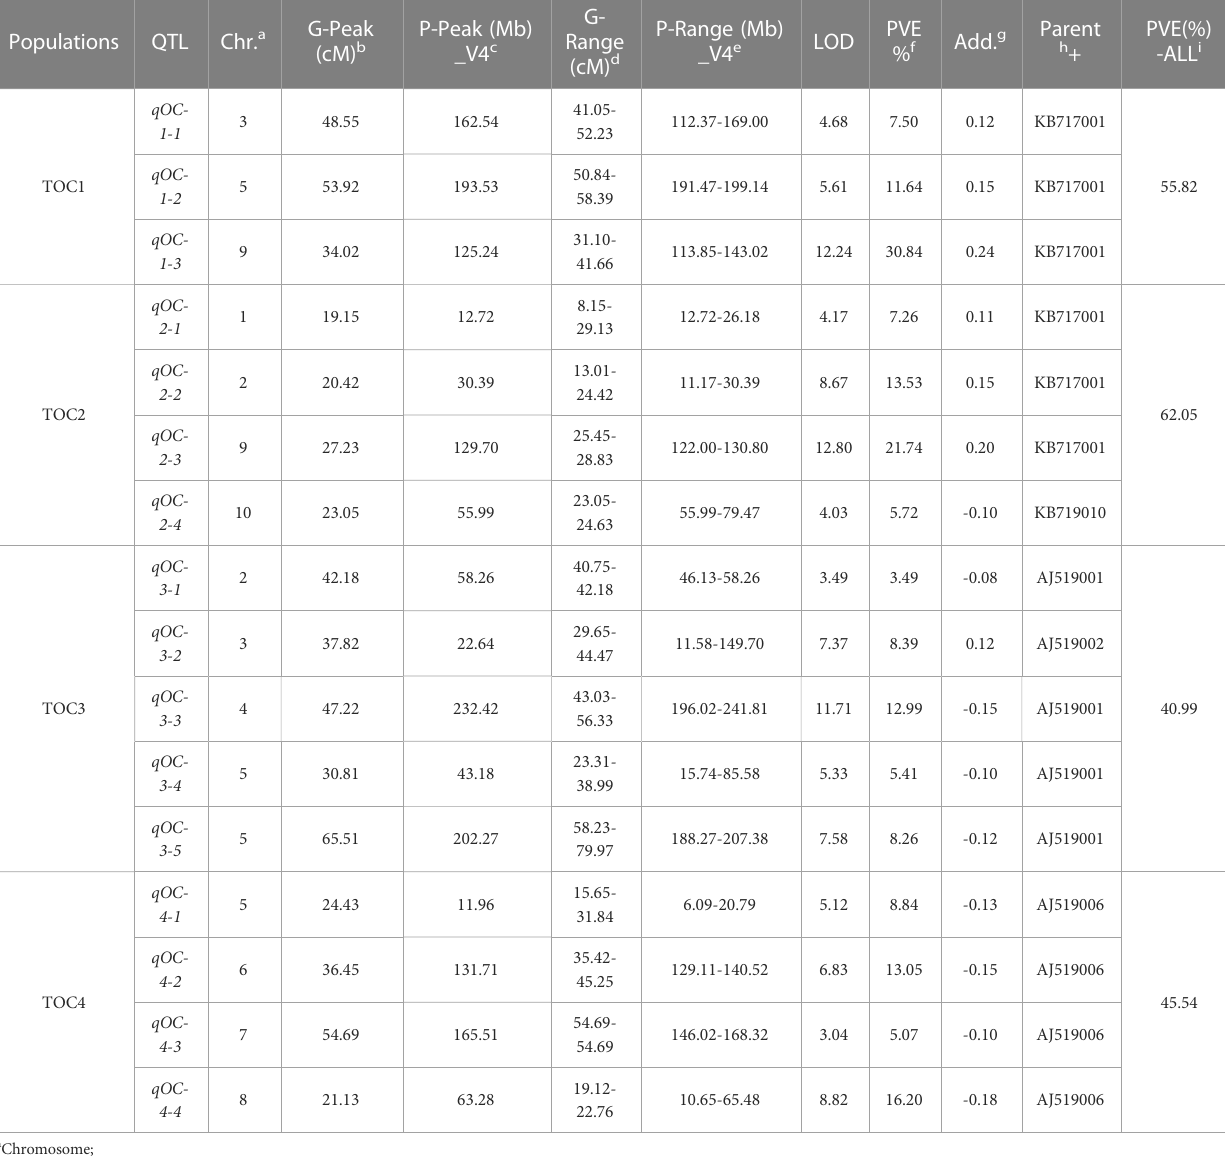
a Chromosome; b Genetic position in centimorgans (cM) of QTL with the highest LOD; c Physical position of QTL based on the B73 reference sequence (V4); d Genetic position range in centimorgans (cM) of QTL with the highest LOD; e Physical position range of QTL based on the B73 reference sequence (V4); f Percentage of the phenotypic variation explained by the additive effect of QTL; g Additive effect of QTL; h which parental allele increased the TOC; i Percentage of the phenotypic variation explained by the additive effect of all